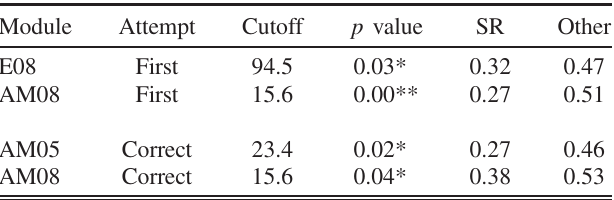
TABLE III. Modules for which a significant difference between the fraction of short attempts among self-reporting (SR) and non- self-reporting (other) students were found. Columns SR and other list the fraction of short attempts detected for each